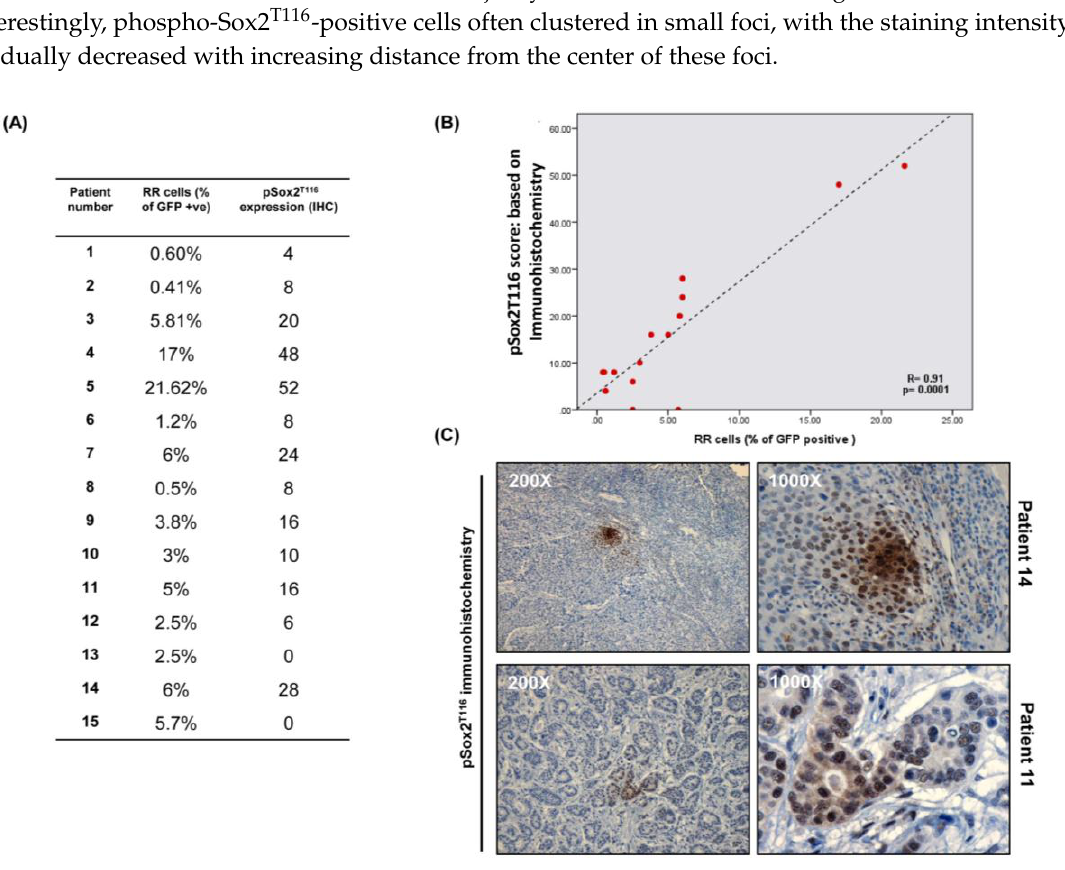
Table 1. Correlation between pSox2T116 expression and clinicopathological features in breast cancer. pSox2 T116 Expression Characteristics Low Expression n (%) High Expression n (%) Total n p Value Age